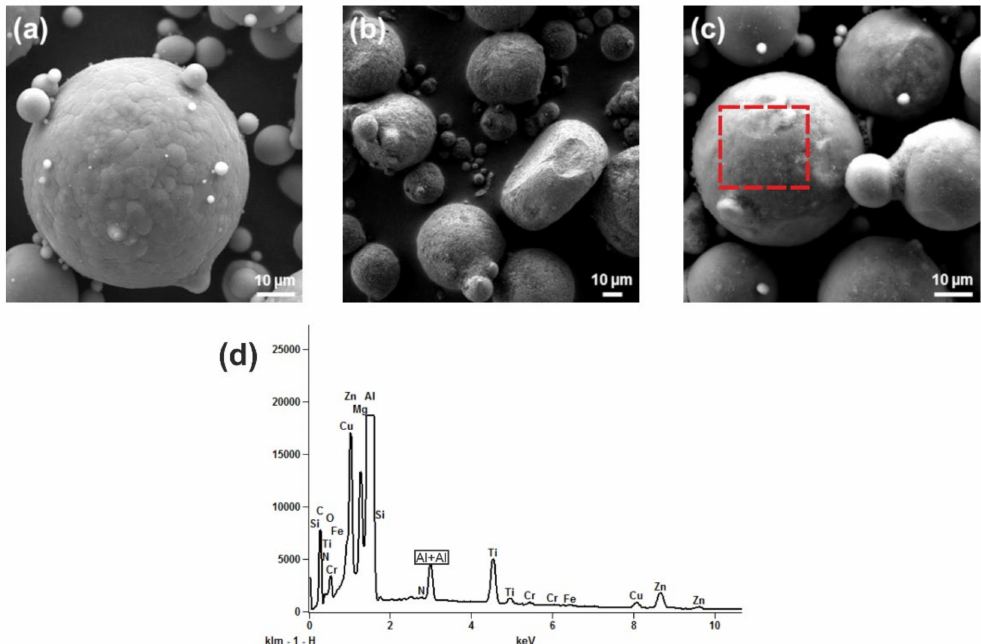
Figure 2. SEM-SE images of powder particles of ( a ) virgin AA7075 powder, ( b ) deformed powder particles of AA7075 pow- der after mechanical decoration with the addition of 2.5 ma% TiC nanoparticles, ( c ) same condition as in ( b ) at a higher magnification, and ( d ) EDX spectra of the dashed outline section highlighted in ( c ).